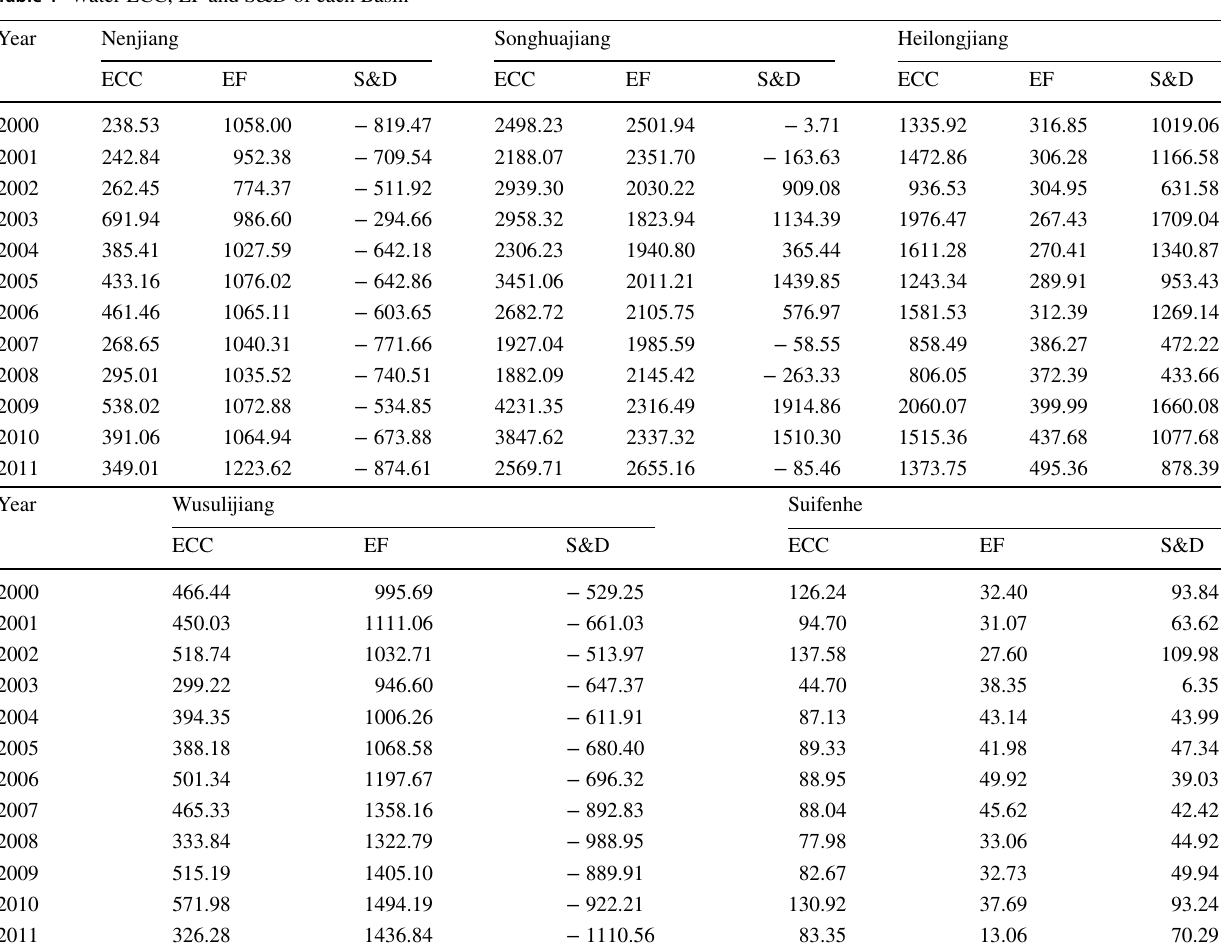
Table 4 Water ECC, EF and S&D of each